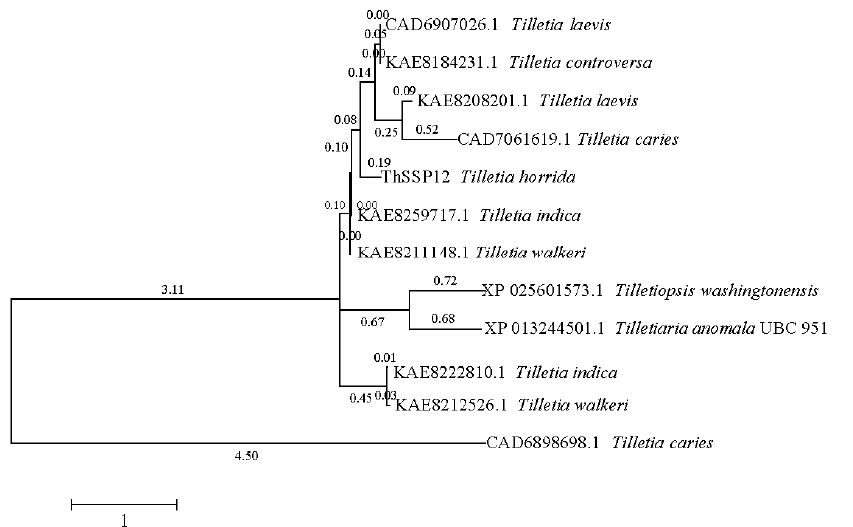
Figure 2. Constructed phylogeny tree of ThSCSP_12 and its homologous secreted proteins.